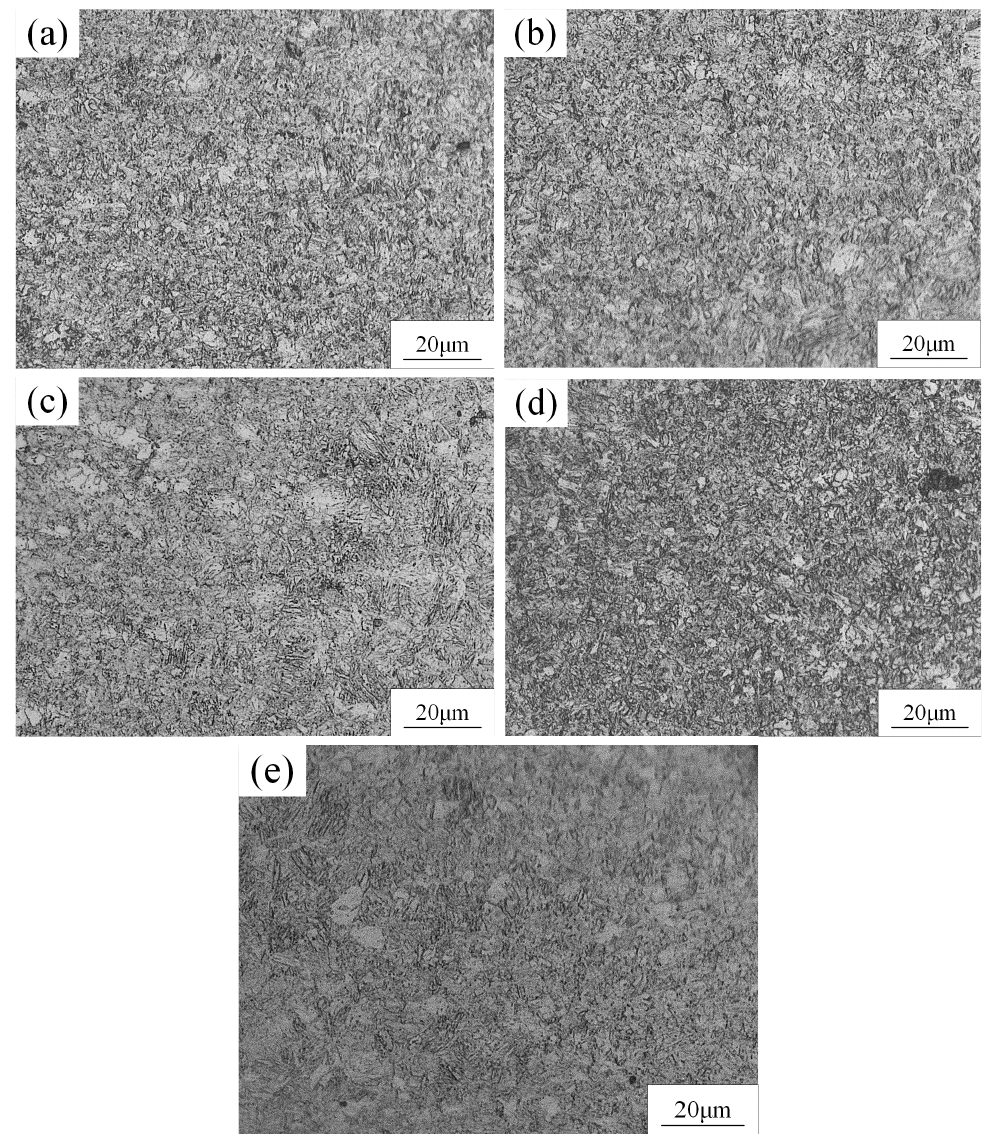
Figure 8. The microstructure of HAZ of DP 780 laser-welded joint under different laser powers